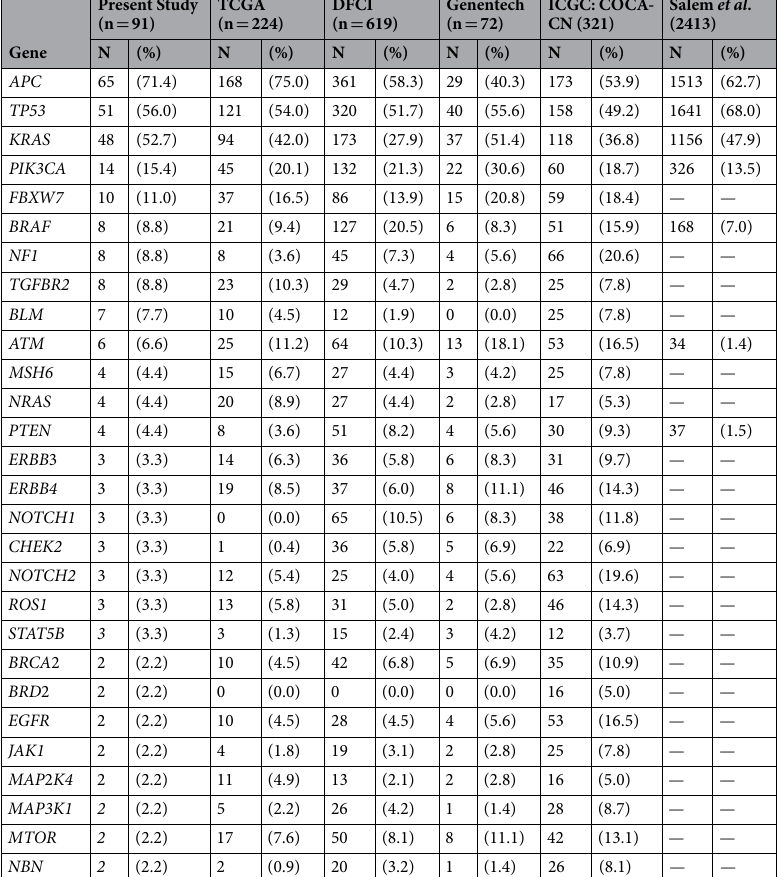
Table 2. Comparison of mutation frequency across different public data (cBioPortal) and studies. TCGA: Comprehensive molecular characterization of human colon and rectal cancer 7 ; DFCI: Genomic Correlates of Immune-Cell Infiltrates in Colorectal Carcinoma 15 ; Genentech: Recurrent R-spondin fusions in colon cancer 19 ; ICGC: COCA-CN: Colorectal cancer from non-Western samples (China) 30 ; Salem et al .: Comparative molecular analyses of left-sided colon, right-sided colon, and rectal cancers 20